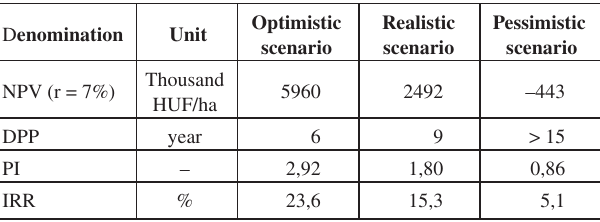
Table 6. Investment Efficiency in Hungarian Apple Production without Investment Subsidies